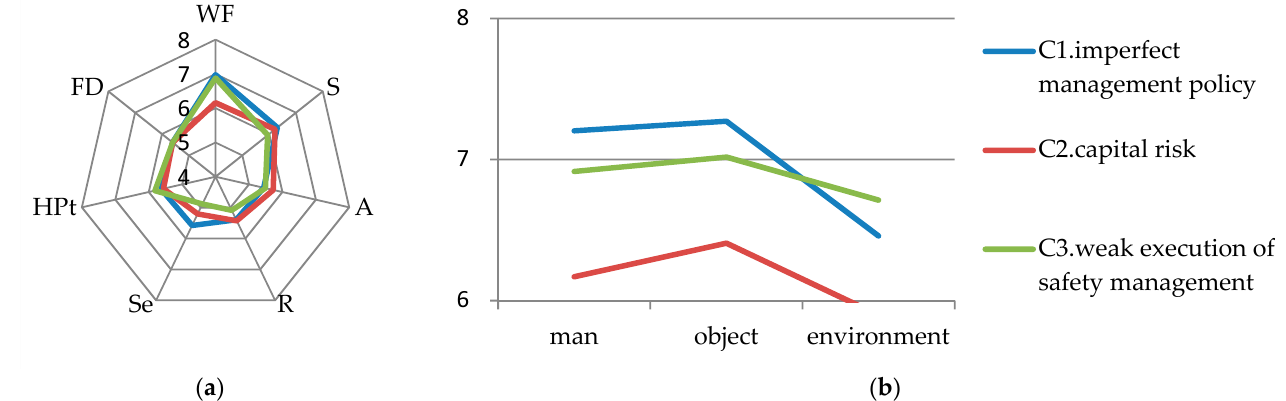
Figure 3. ( a ) Parameters scores for management factors; ( b ) detailed scores of WF for management factors.